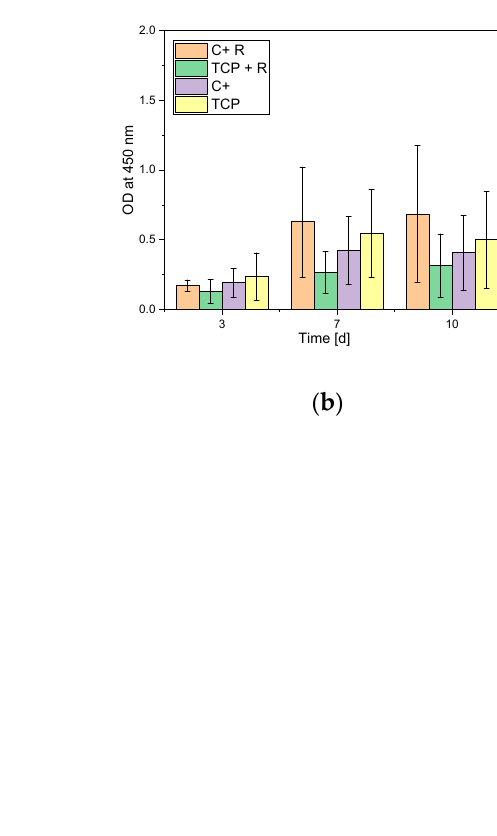
Figure 6. Living cells in percent for the different scaffolds a : 500 µm; b : 750 µm; and c : 1000 µm .